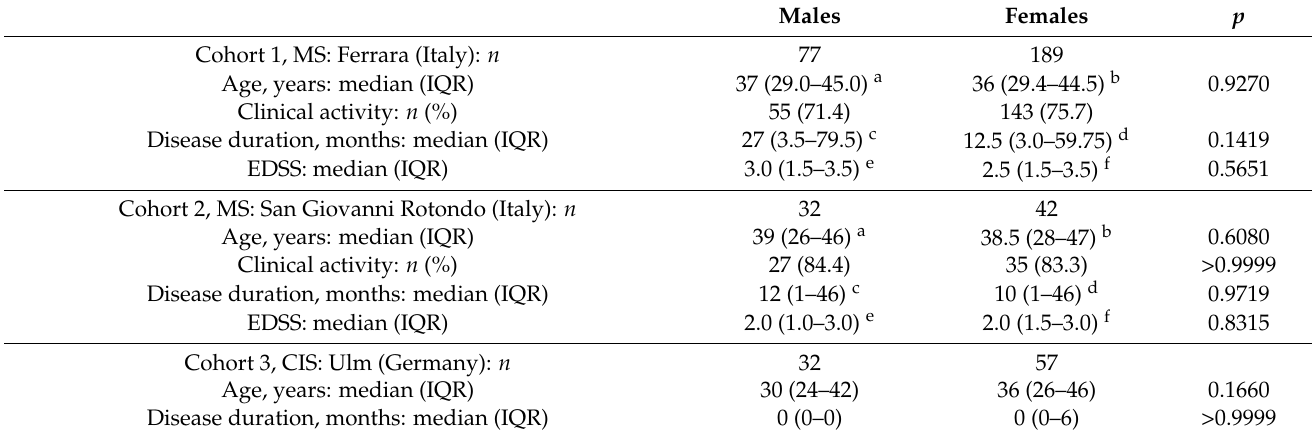
Table 1. Demographic and clinical characteristics of the study population. Cohort 1 and cohort 2 included patients with multiple sclerosis (MS), while cohort 3 included patients with the clinically isolated syndrome (CIS). Data were referred to the time of lumbar